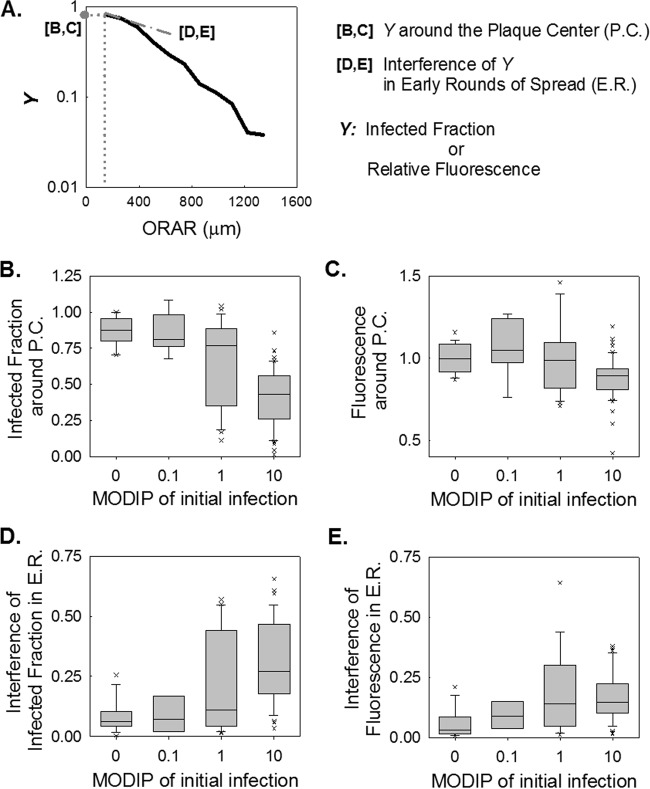
Interfering effects of DIPs on viral activity during infection spread. (A) Schematic illustration of how parameters are extracted from data depicting the infection measure (Y) versus the outer radius of each analyzed ring (ORAR). (B to E) Distributions of extracted features at each MODIP (abscissa) are shown as box plots. The gray boxes cover 25%-to-75% confidence intervals, while the whiskers span 5% to 95%. The horizontal lines in the boxes represent medians, and each outlier is indicated by a lowercase letter x. The infected fraction (B) and relative fluorescence (C) around the plaque center (P.C.), as well as the interference with these values within ∼8 cell diameters in early rounds of spread (E.R.) (D and E), were extracted from the infected fraction and relative fluorescence over the ORAR trajectories of the individual plaques shown in Fig. 3C and D.